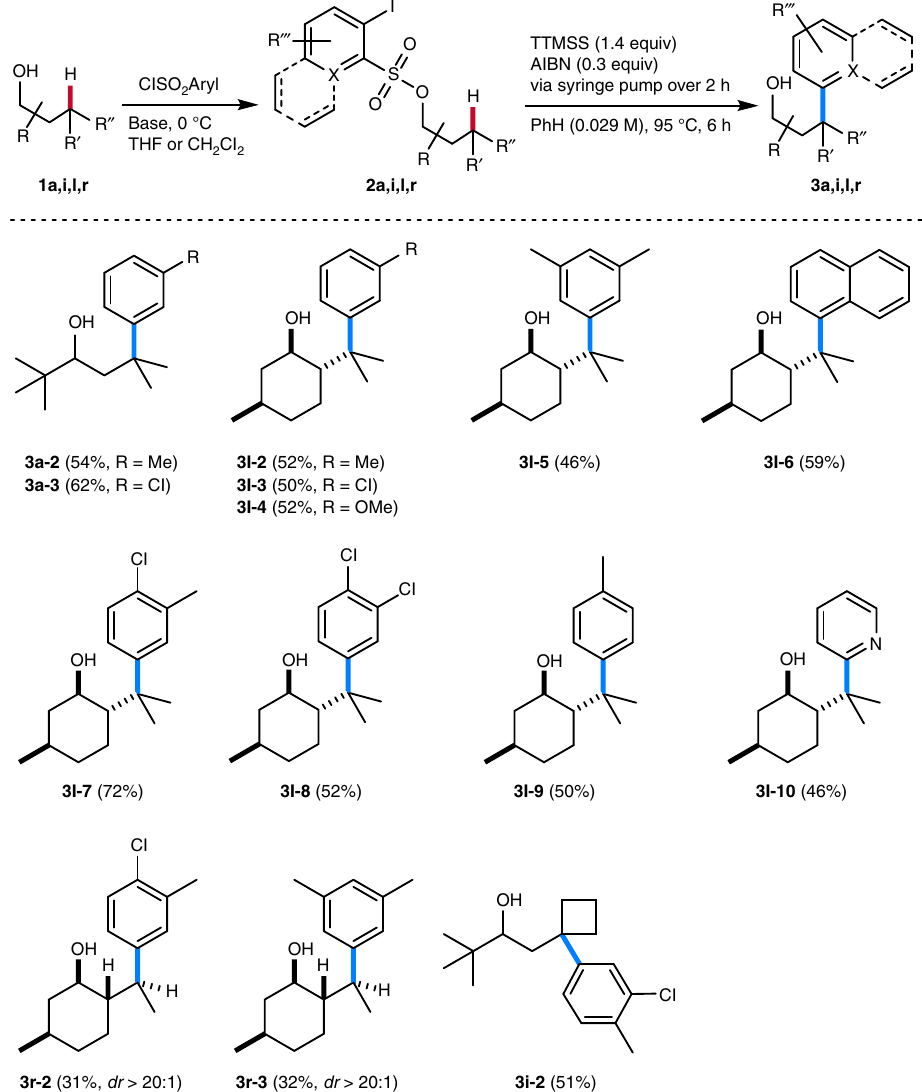
Fig. 3 Variation of alcohol and arylating translocating group. Sulfonylation conditions: ClSO 2 Aryl, Me 3 N·HCl, Et 3 N, ROH in CH 2 Cl 2 at 0 °C or ClSO 2 Aryl, Me 3 N, ROLi in THF at 0 °C, see Supplementary